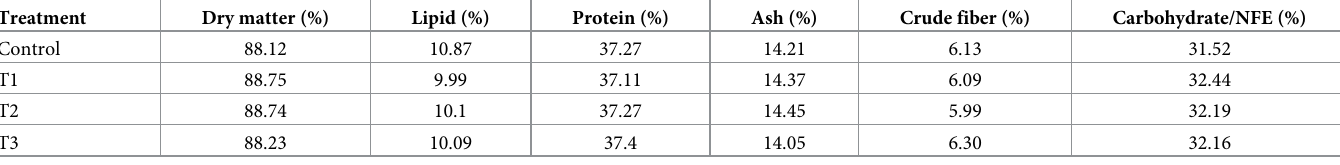
Table 2. Estimation of the proximate composition of control feeds and individual graded levels of dietary chitosan-treated feeds (dry matter basis) for rearing B . gonionotus .